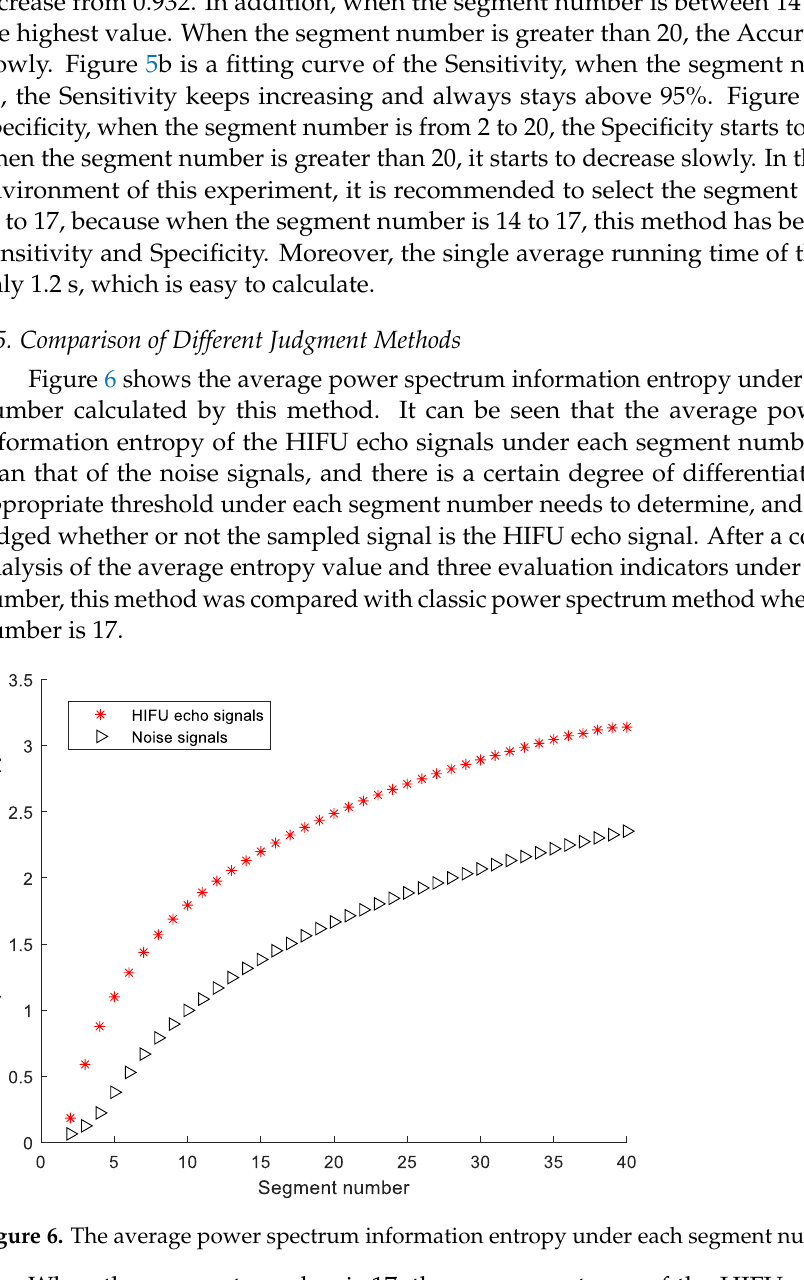
Table 1. Comparison of consistency between the two methods.